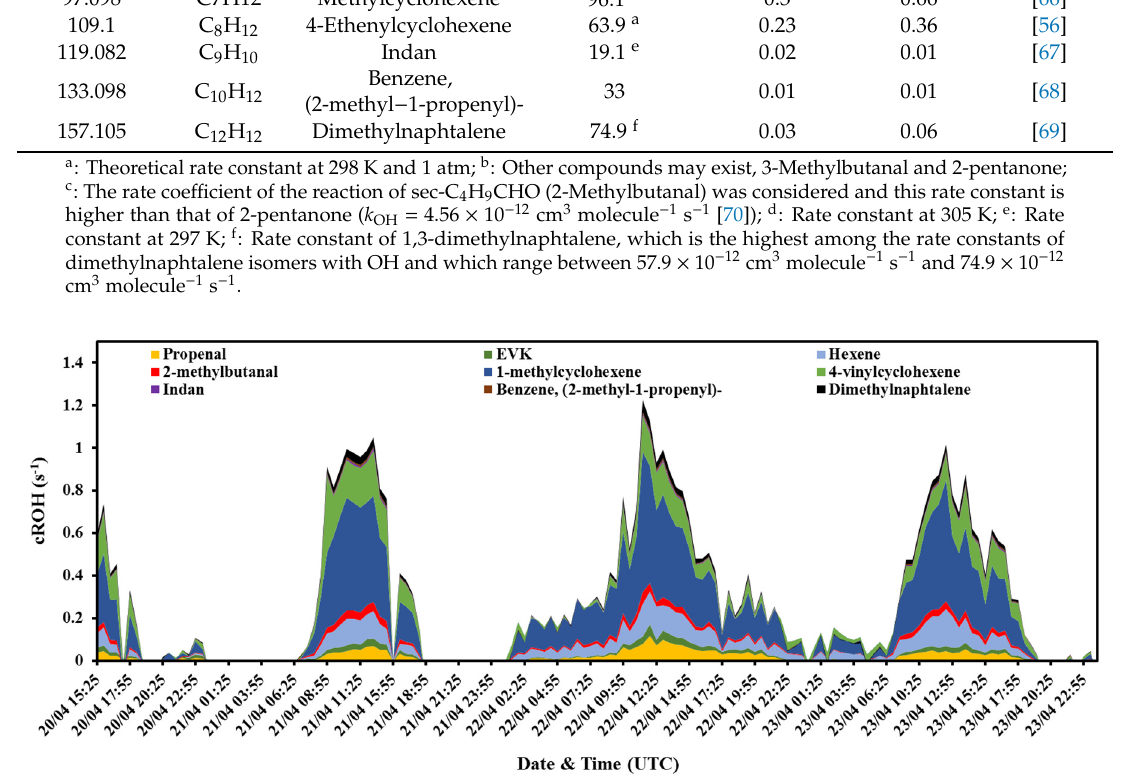
Figure 7. Summed calculated OH reactivity of the 9 additionally selected compounds. The mixing ratios used for the calculation correspond to the ones from the rapeseed branch (VOCs rapeseed ) and the k i-OH are the ones mentioned in Table 4.